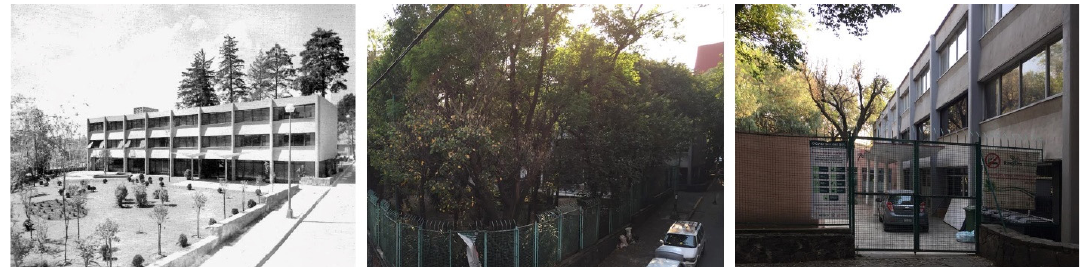
Figure 9. Exterior views of the Casa de la Asegurada in the Unidad Independencia housing complex. This Casa was inaugurated in 1960 as a Social Security and Health Center; however, its organization, design, and execution were conceived in 1958–1959 by the team of architects Alejandro Prieto, Jos é Mar í a Gut í errez, Pedro F. Miret, Manuel Santiago, Manuel Rom á n, Carlos Villaseñor, and Leonel P é rez, under the design guidelines of the Casas de la Asegurada, being this the last one designed in Mexico City under these characteristics. From left to right: bird’s eye view of its original state in 1960, bird’s eye view (same angle) of its current state, and eye-level view of the entrance portico. The comparison shows the canopy and the facade, the emergence of the fence on the perimeter of the garden, the growth of trees, and the emergence of improvised elements that exclusively serve the Casa de la Asegurada. Source: left, Foto Estudio Brehme, “Casa de la Asegurada”, published in “Unidad de servicios sociales y de habitación Independencia”, Arquitectura México, núm. 73. Mexico, 1961, p. 31; [41]; middle and right, own creation, 2021.